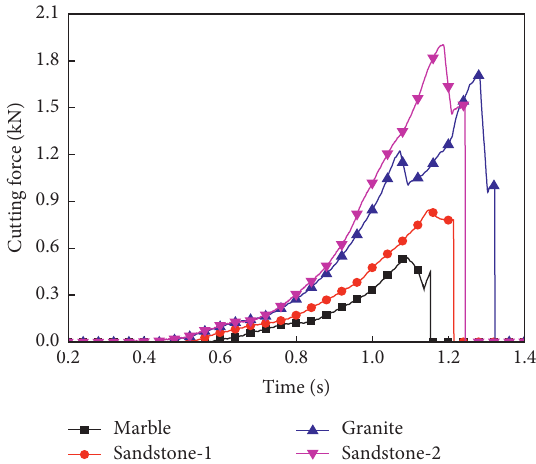
Figure 13: Variation in cutting force with time.